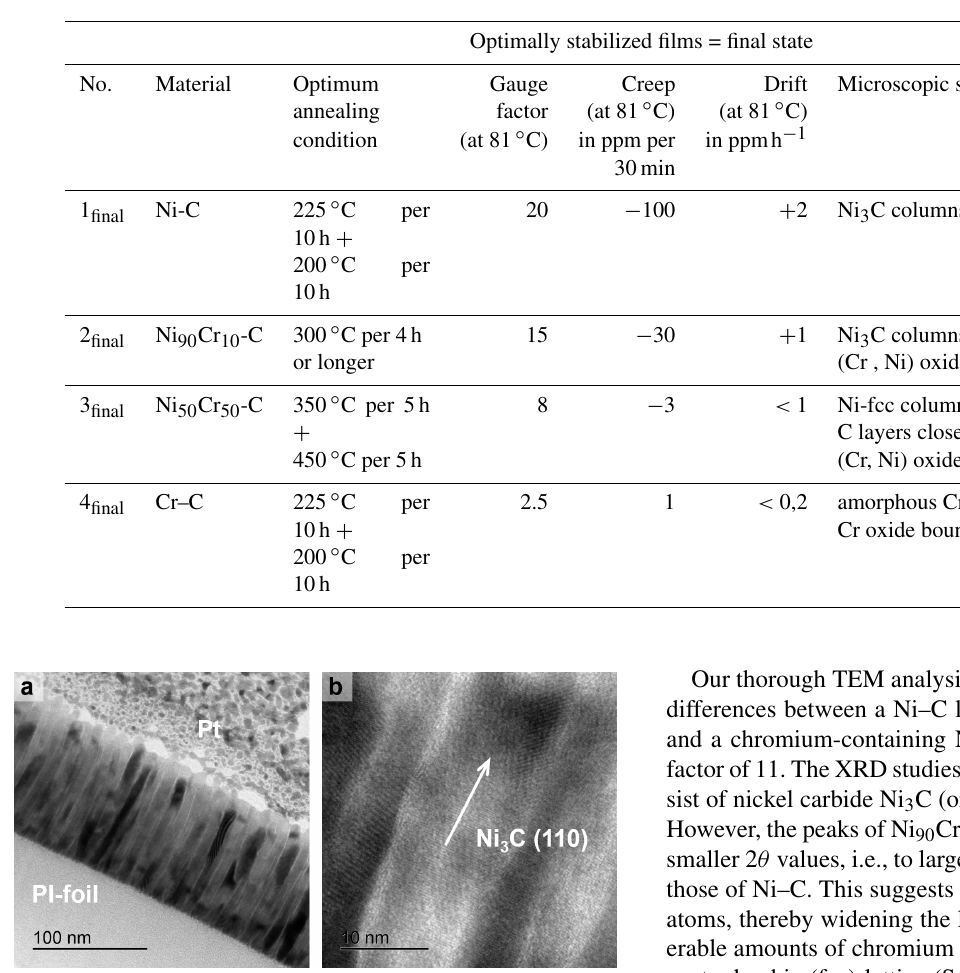
Table 2. Final mechano-electrical quantities of the films after the thermal treatment in air, which is considered as optimal. The optimum annealing conditions in each case are given in the third column. In some cases, the microscopic structural features, which are again noted in the last column, are altered compared to the initial state.